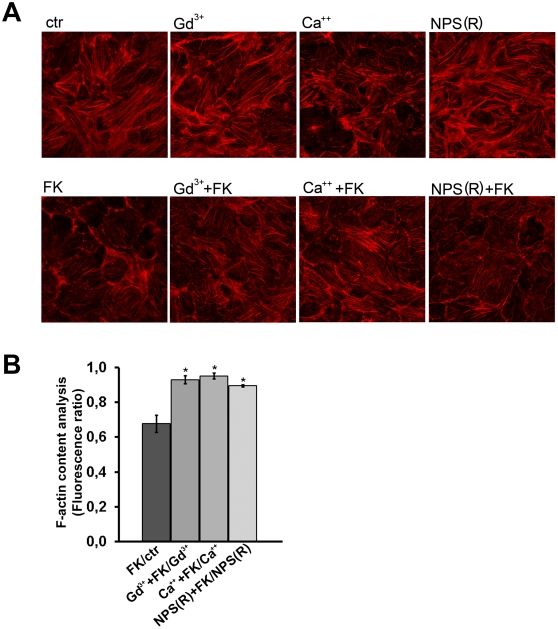
Actin cytoskeleton in cells exposed to CaR agonists.A. Visualization of actin cytoskeleton. MCD4 cells were preincubated with 5 mM Ca2+, 300 µM Gd3+ or 10 µM NPS-R 568 for 30 min and then stimulated with 10-4 M FK or analyzed at rest. Cells were fixed in PFA and stained with phalloidin Alexa Fluor-555 to visualize F-actin. Confocal pictures were taken for each experimental condition. Experiments were performed three times with similar results. B. F-actin quantization by actin polymerization assay. Confluent cells were either left untreated (CTR) or stimulated with forskolin (FK) or treated as described above with CaR agonists. After staining with TRITC-phalloidin, cells were extracted with cold methanol and the fluorescence absorbance of extracts was read (540/565 nm). The values obtained were compared by a one-way Anova and Newman-Keuls multiple comparison test (#P<0.05).